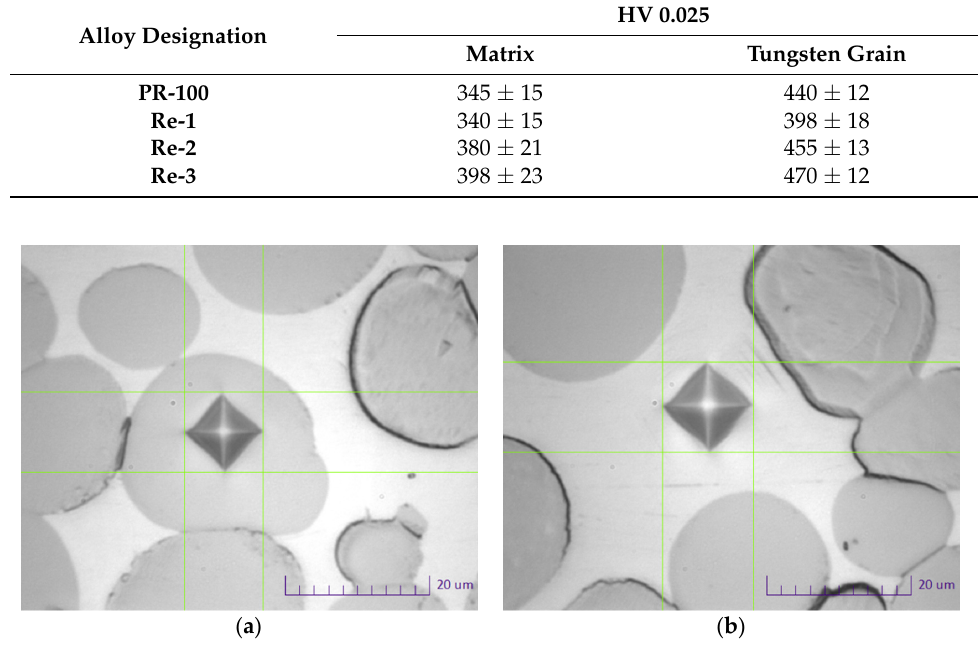
Figure 5. Sample photos of measuring microhardness of tungsten grains ( a ) and matrix ( b ).